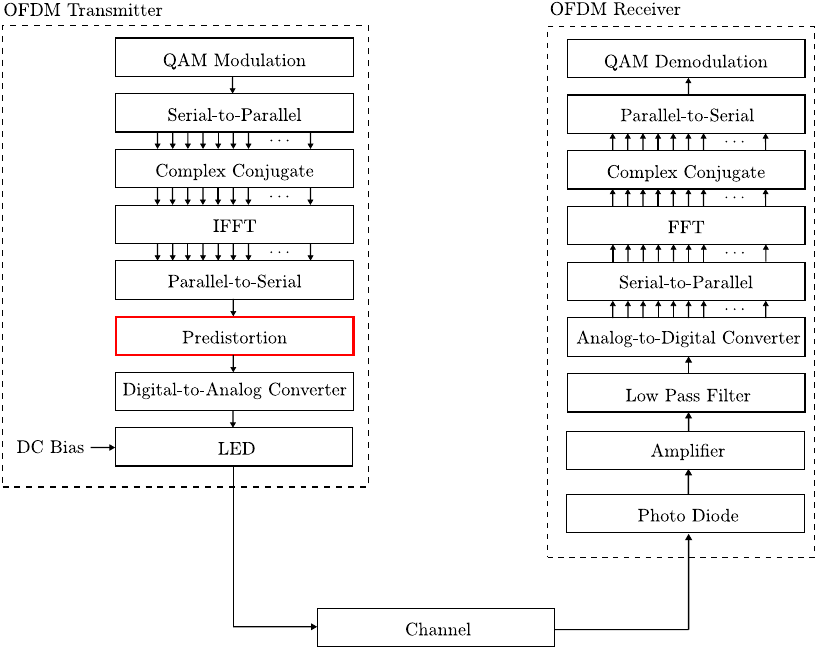
Figure 3. A block diagram of OFDM transceiver using